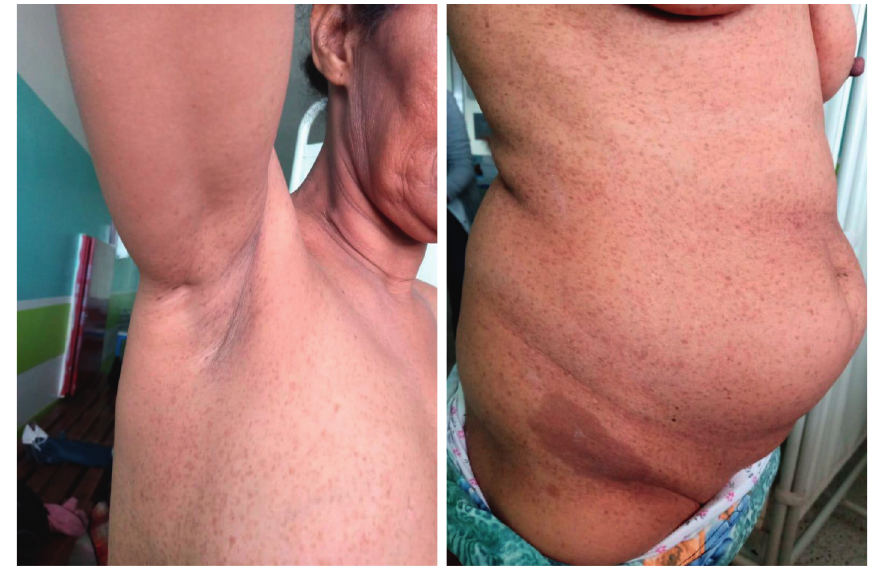
Figure 1: Hyperpigmented skin macules with multiple caf´e-au-lait spots, axillary, and inguinal freckling in her mother.